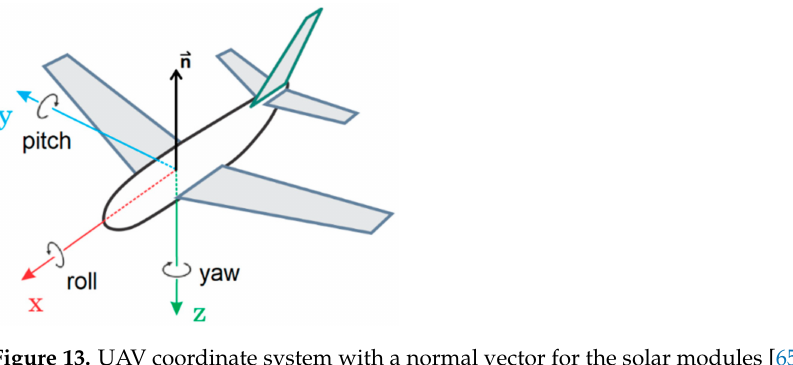
Figure 13. UAV coordinate system with a normal vector for the solar modules [65]. Letters x, y and z present name of Cartesian coordinate system axis and letter n presents a normal vector of solar modules plane. Figure is adapted from PX4 User Guide (Documentation) web page (CC BY